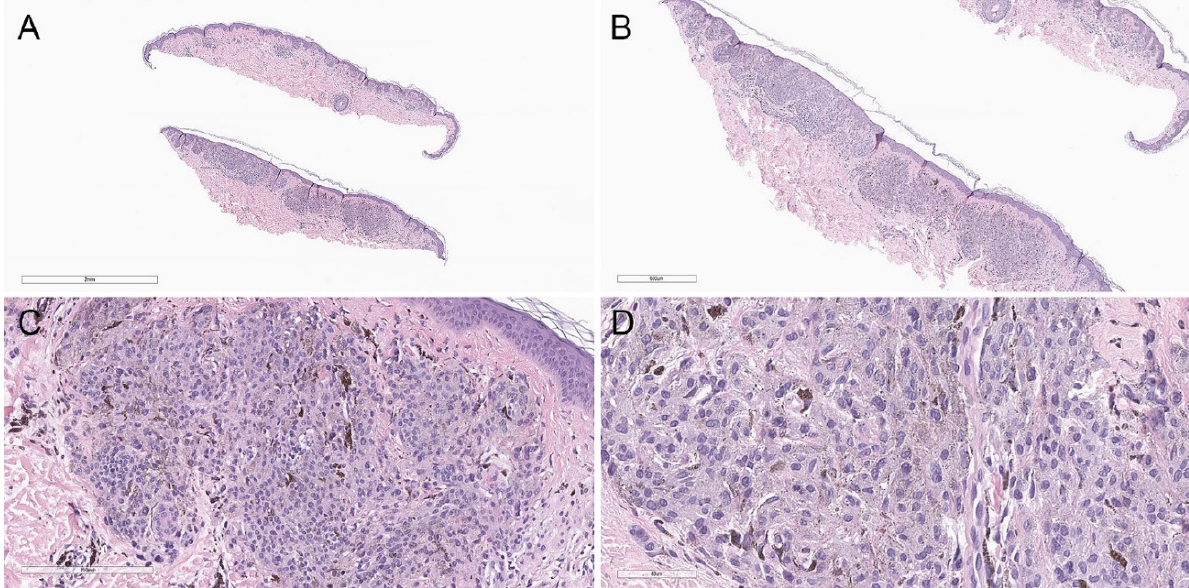
Figure 8. Deep penetrating nevus–like melanoma showing a compound, asymmetric melanocytic proliferation. ( A ) Hematoxylin and eosin, 20×. ( B ) Hematoxylin and eosin, 40×. ( C ) Lesional cells share cytomorphologic similarity with conventional deep penetrating nevus (hematoxylin and eosin, 200×). ( D ) However, there is increased cytologic atypia (hematoxylin and eosin, 400×). Additionally, immunohistochemical studies showed diffuse loss of p16, and the MyPath Myriad score (from qRT-PCR-based molecular analysis) was 2.0 (benign, − 16 to − 2; intermediate, − 2 to 0; malignant, 0 to 10), supporting the interpretation of melanoma.